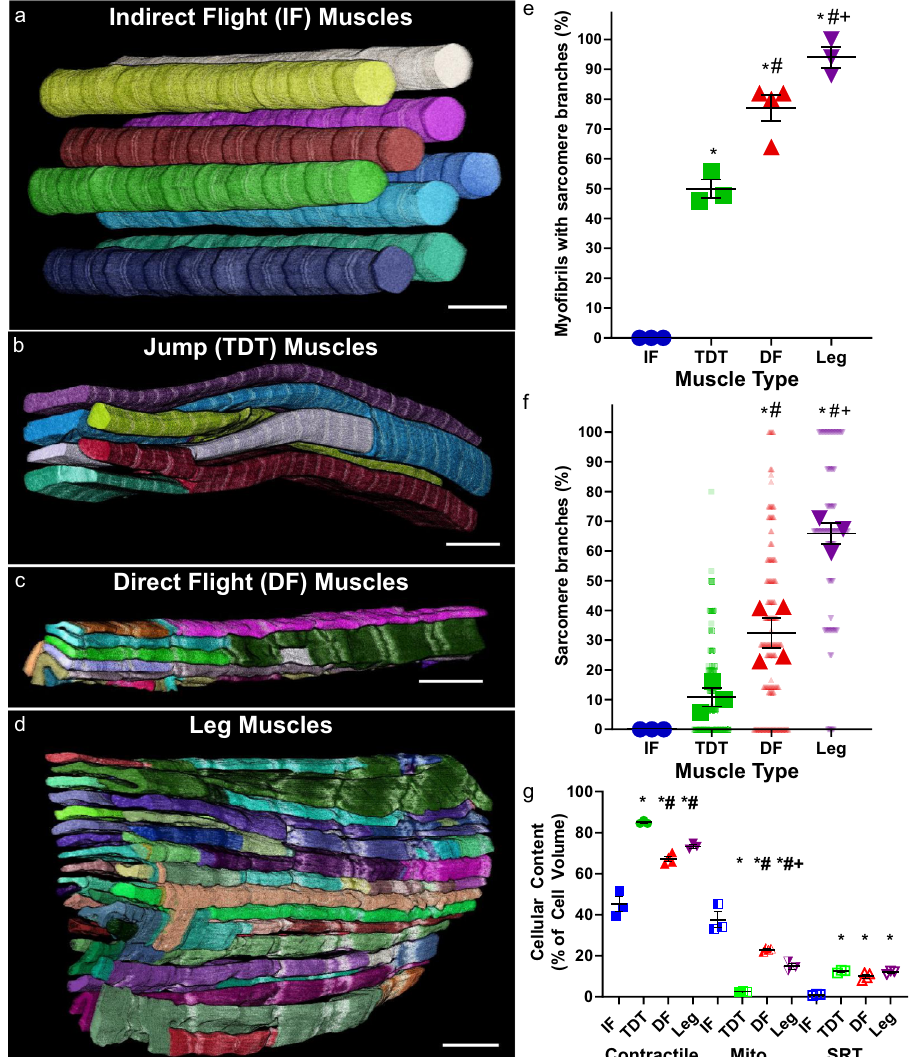
Fig. 1 Myo fi brillar networks in Drosophila skeletal muscles. a 3D rendering of isolated myo fi brils in fi brillar indirect fl ight (IF) muscles. b – d 3D rendering of uni fi ed myo fi brillar matrix structures in tubular muscles. b Jump (tergal depressor of the trochanter, TDT) muscles; c — direct fl ight (DF) muscles; d — leg muscles. Individual colors represent different myo fi brillar segments separated by sarcomere branches. e Percentage of myo fi brils with at least one branching sarcomere in wild-type IF, TDT, DF, and leg muscles. Asterisk (*): Signi fi cantly different from fi brillar indirect fl ight (one-way ANOVA, P <0.0001). Hash sign (#): Signi fi cantly different from tubular TDT (DF: P = 0.0015, Leg: P <0.0001). Plus sign ( + ): Signi fi cantly different from tubular DF ( P = 0.0267). f Percentage of sarcomeres per myo fi bril with at least one branch in wild-type IF, TDT, DF, and leg muscles. Asterisk (*): Signi fi cantly different from fi brillar indirect fl ight (DF: P = 0.0008, Leg: